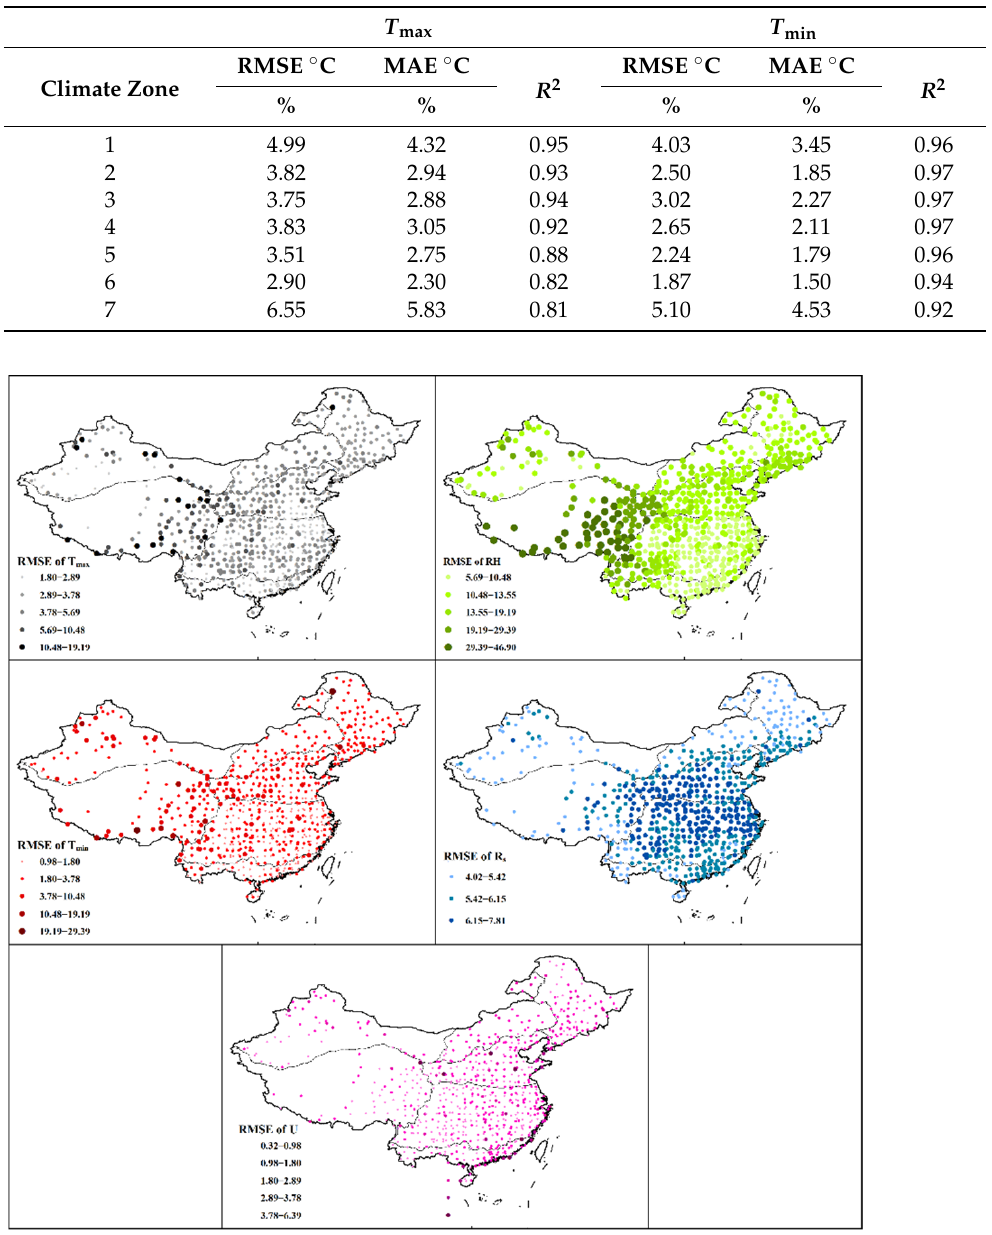
Figure 3. MAE values of the five meteorological factors of in all stations.